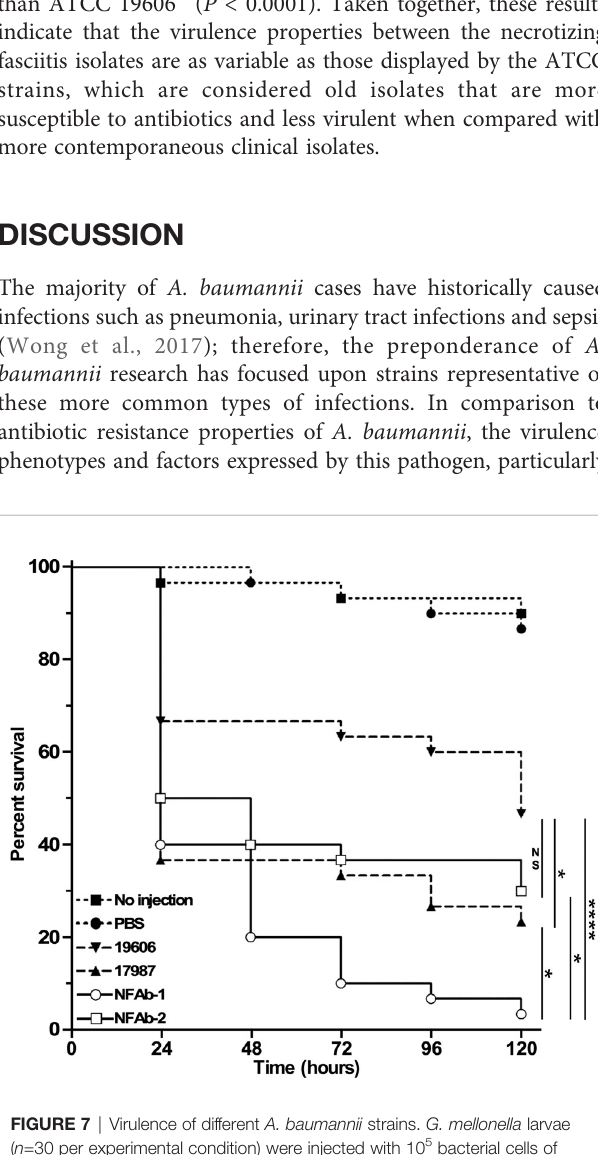
FIGURE 6 | Intracellular invasion of A. baumannii strains into A549 respiratory epithelial cells. Surviving intracellular bacteria were collected after 2 hours of culture with A549 cells followed by a 30-min incubation in the presence of 50 m g/ml colistin. The number of bacteria surviving within A549 cells are reported as colony forming units (CFUs) obtained from triplicate independent biological samples. Horizontal bars identify statistically different values ( P ≤ 0.01, **; P ≤ 0.001, ***; NS, not signi fi cant) and error bars represent the standard error of each data set.